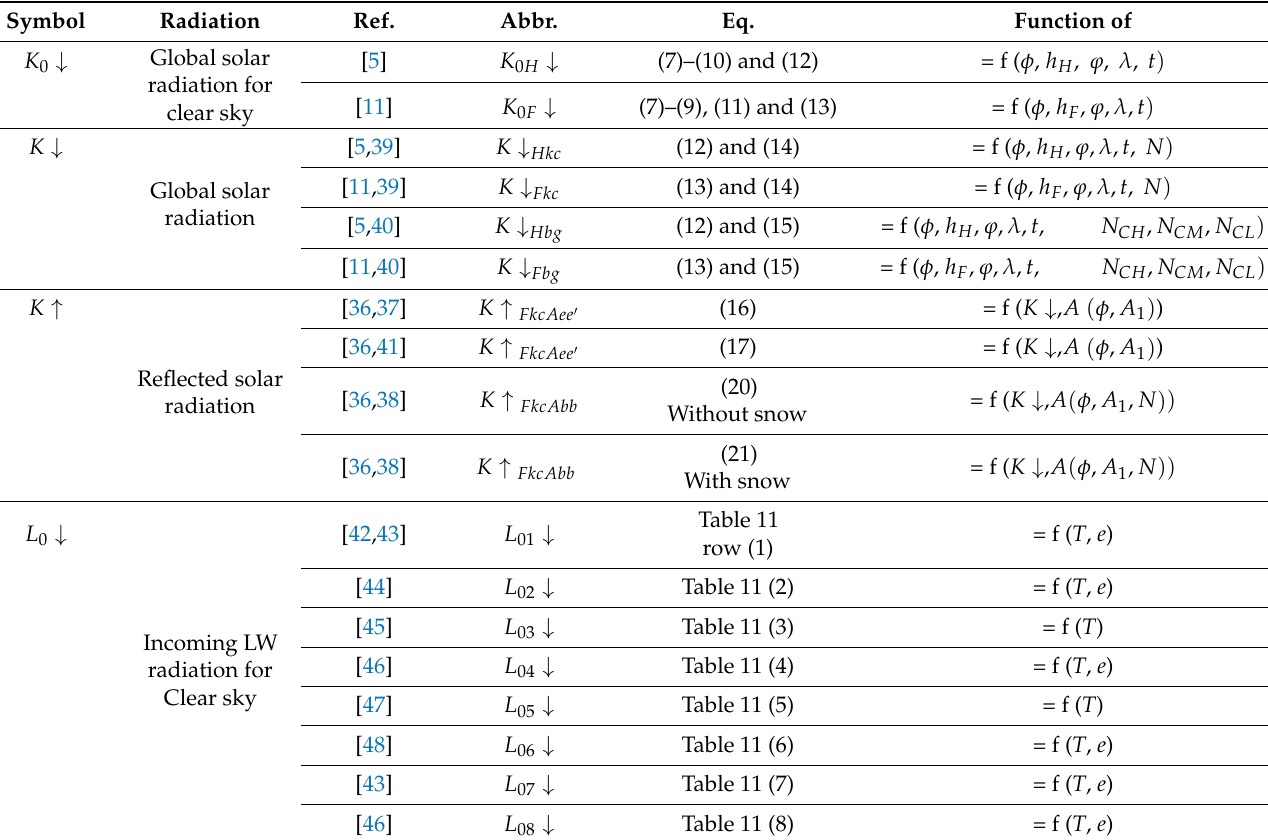
Table 1. List of applied parameterizations for radiation budget components. ( K ↓ , K ↑ , L ↓ , L ↑ and Q ∗ are calculated, and K inp and Q net are the measured values. Symbol Radiation